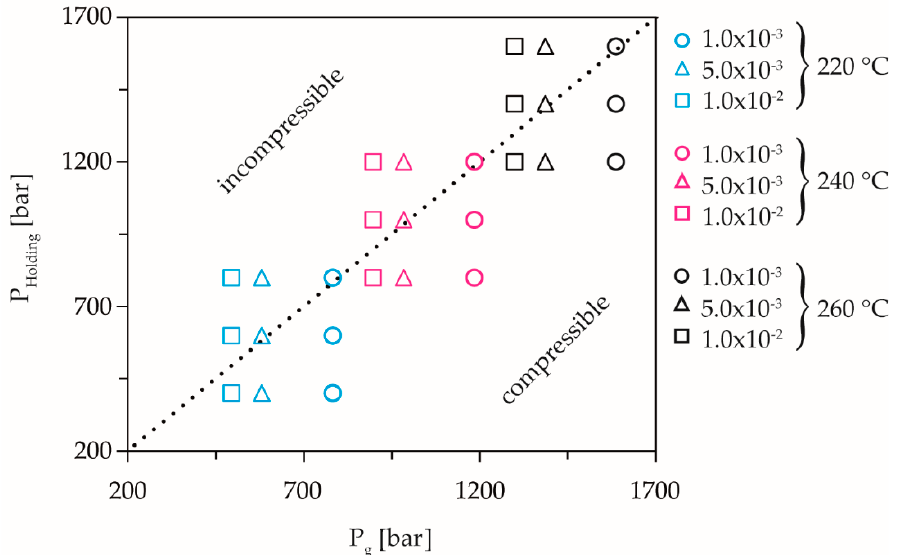
Figure 5. Depiction of the selected holding pressures in comparison to the calculated dynamic pressure-induced solidification pressures according to Roth et al. [38]. Reprinted with permission from ref. [38]. Copyright 2020 Copyright Polymers.